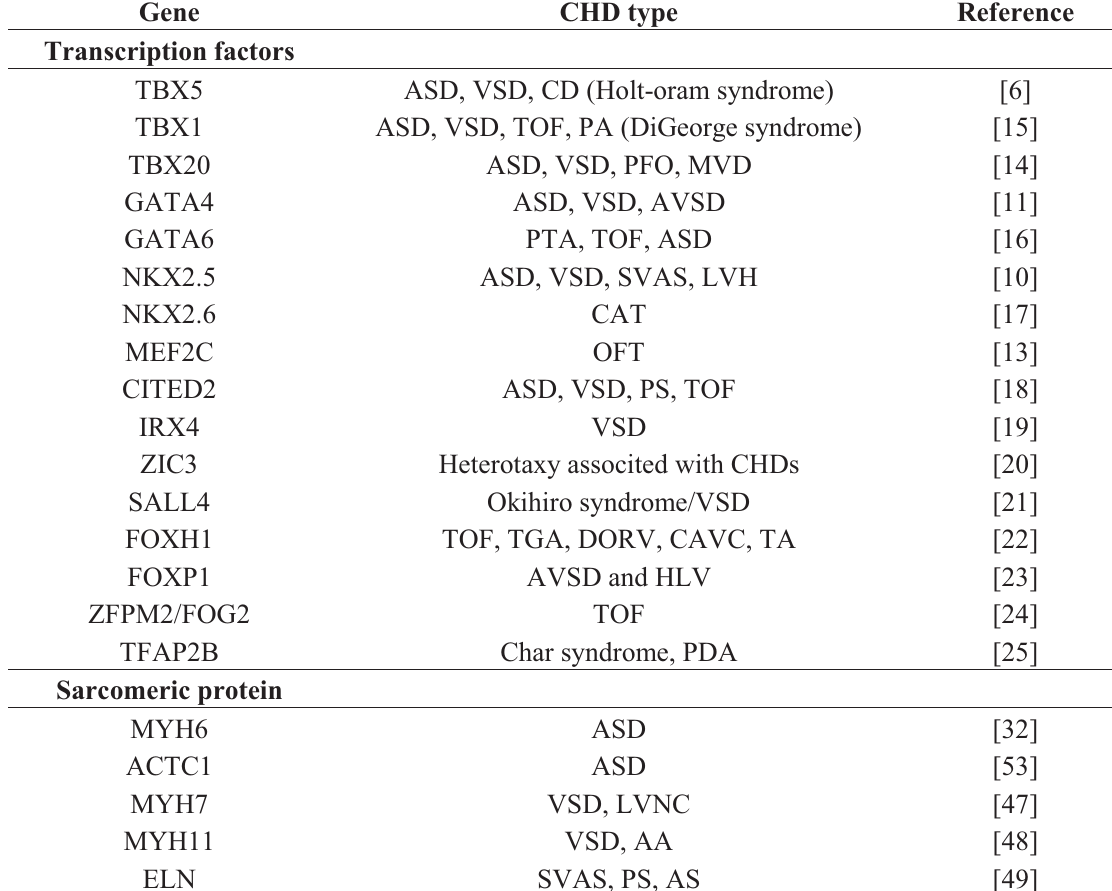
Table 1. List of genes encoding transcription factors and structural proteins that are associated with CHDs in human. Abbreviations: AA-Aortic Aneurysm; AS-Aortic Stenosis; ASD-Atrial Septal Defect; AVSD-Atrioventricular septal defects; CD-Conduction Defects; CHD-Congenital heart disease; CAVC-Common Atrioventricular Canal; CAT-Common arterial Trunk; DORV-Double Outlet Right Ventricle; HLV-Hypoplastic Left Ventricle; LVH-Left Ventricular Hypertrophy; LVNC-Left Ventricular Noncompaction; MVD-Mitral Valve Disease; PA-Pulmonary Atresia; PDA-Patent Ductus Arteriosus; PFO-Persistence of Foramen Ovale; PS-Pulmonary Stenosis; SVAS-Subvalvular Aortic Stenosis; TOF-Tetralogy of Fallot; TGA-Transposition of Great Arteries; VSD-Ventricular Septal Defect. Gene CHD